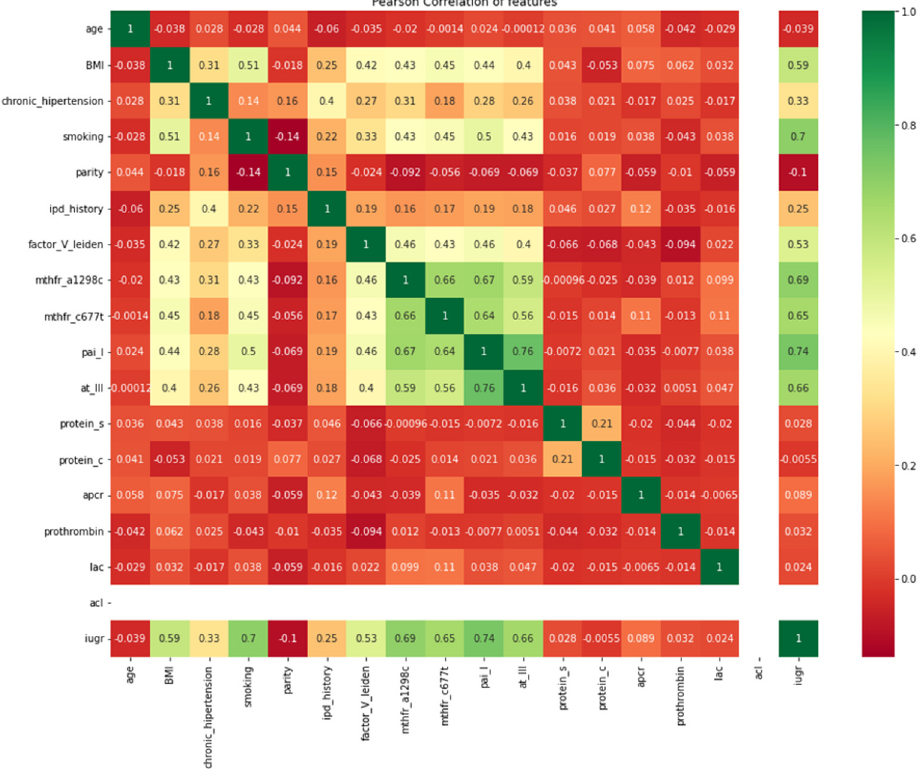
( r = 0.74), current smoking status ( r = 0.7), MTHFR A1298C homozygous ( r = 0.69), MTHFR C677T homozygous ( r = 0.65), antithrombin III ( r = 0.66), and factor V Leiden ( r = Figure 5. Graphic representation of the Pearson correlation matrix for the included predictors.